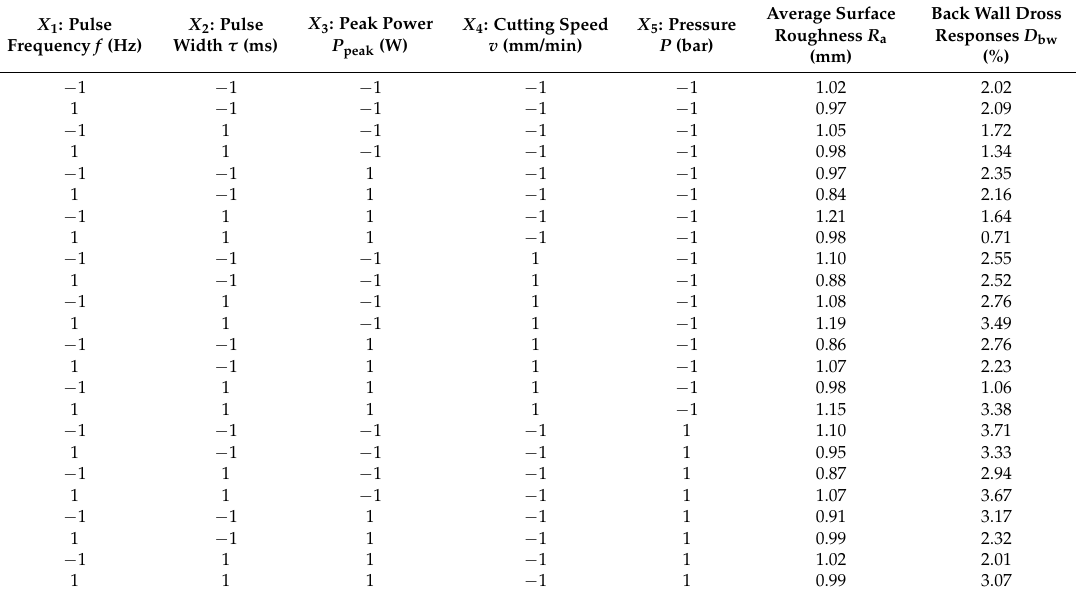
Table A2. Complete data set for miniature tube type